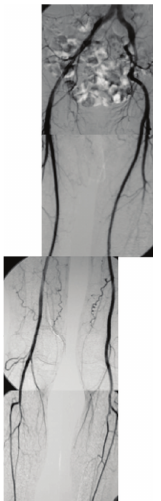
Figure 3: Case 2: preoperative arteriography showed that the popliteal artery was occluded, but there were no abrupt interrup- tions in the tibial or peroneal